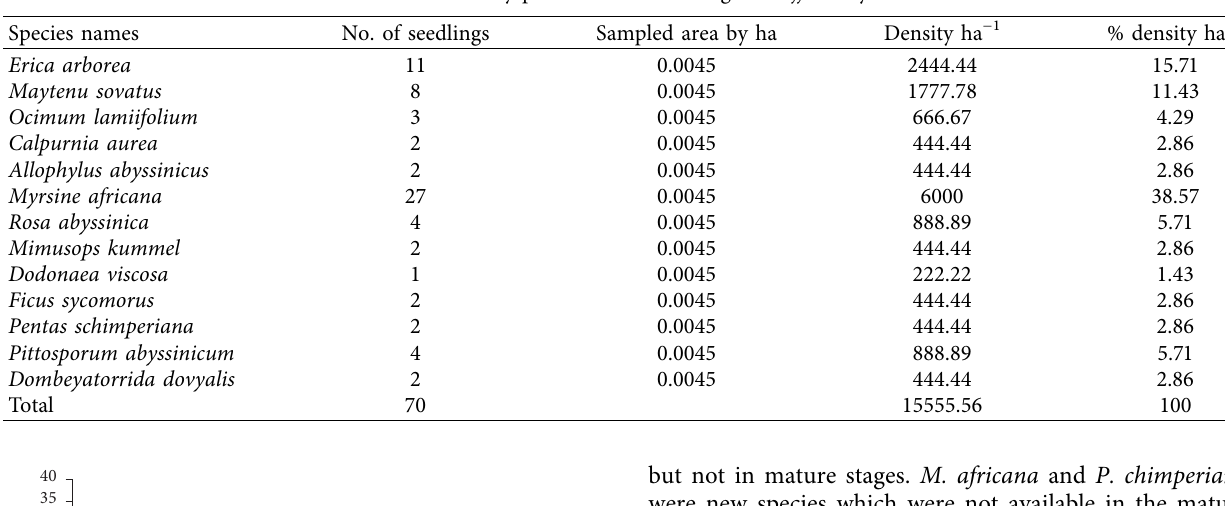
Table 7: Abundance and density per hectare of seedlings of Zijje Maryam Church Forest.